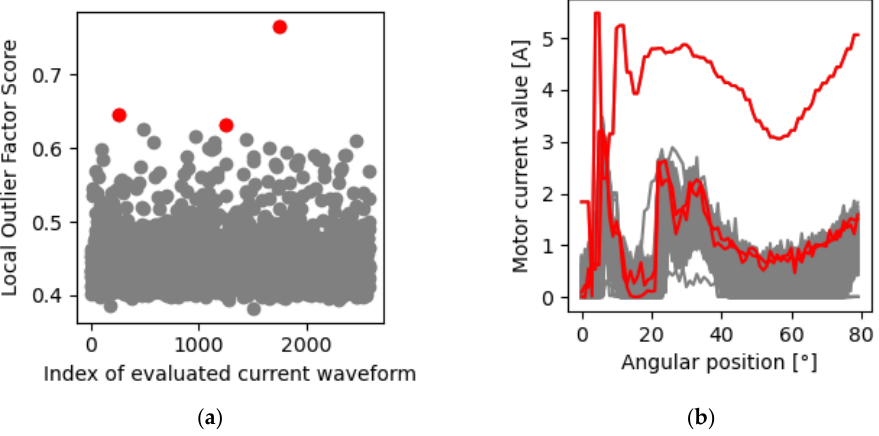
Figure 7. ( a ) iForest raw scoring function on the whole training dataset (boom moving down); ( b ) Three most anomalous waveforms (red) among the whole training dataset (grey). Isolation forest correctly classified the most outlying waveform, but incorrectly classi- fied the other